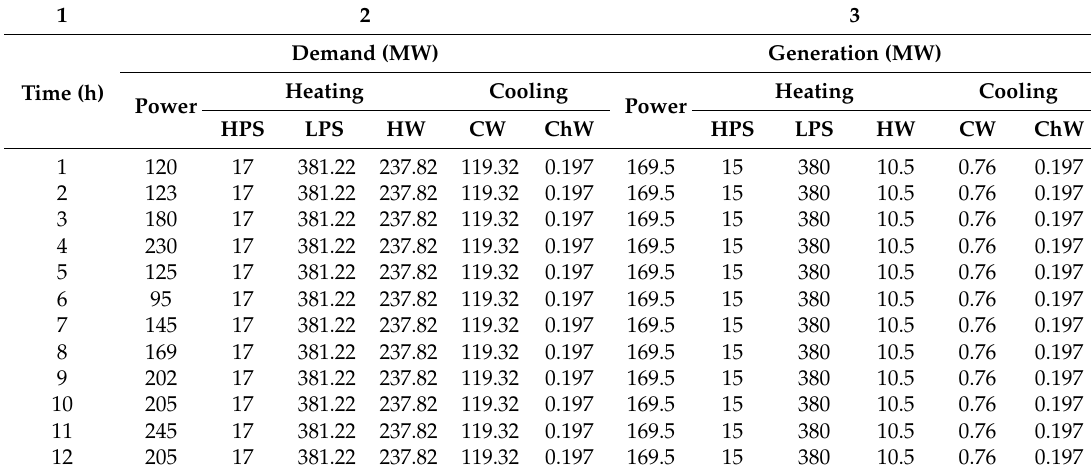
Table A1. TriGenSCA before iteration from time 1 to 12 h.